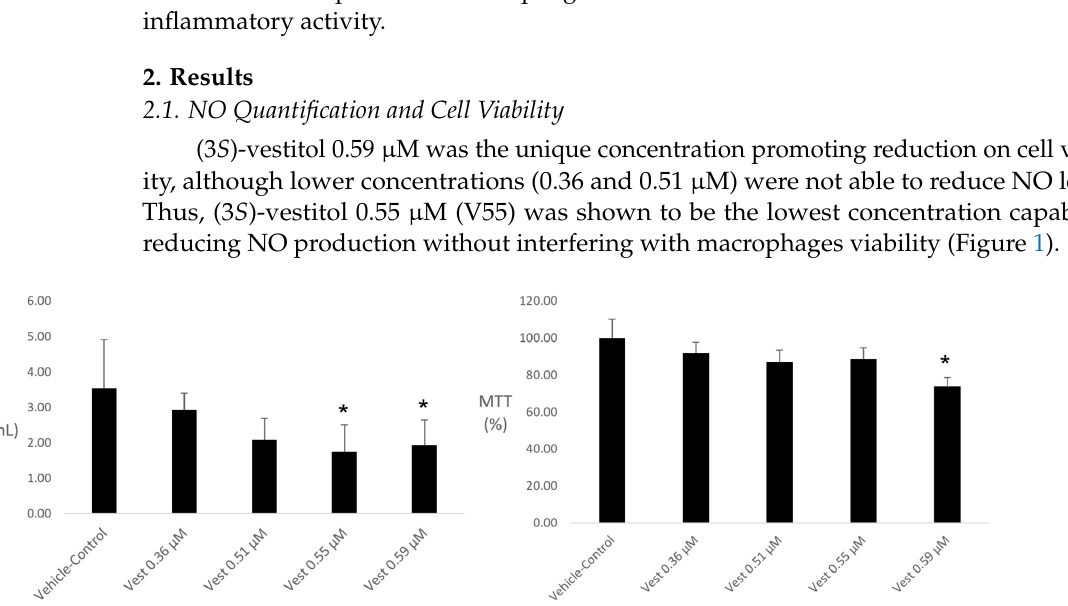
Figure 1. (3 S )-vestitol effects on NO release and macrophage viability of LPS-stimulated peritoneal cells (n = 6). * statistical difference compared to control group by one-way ANOVA plus Tukey post-hoc test, p